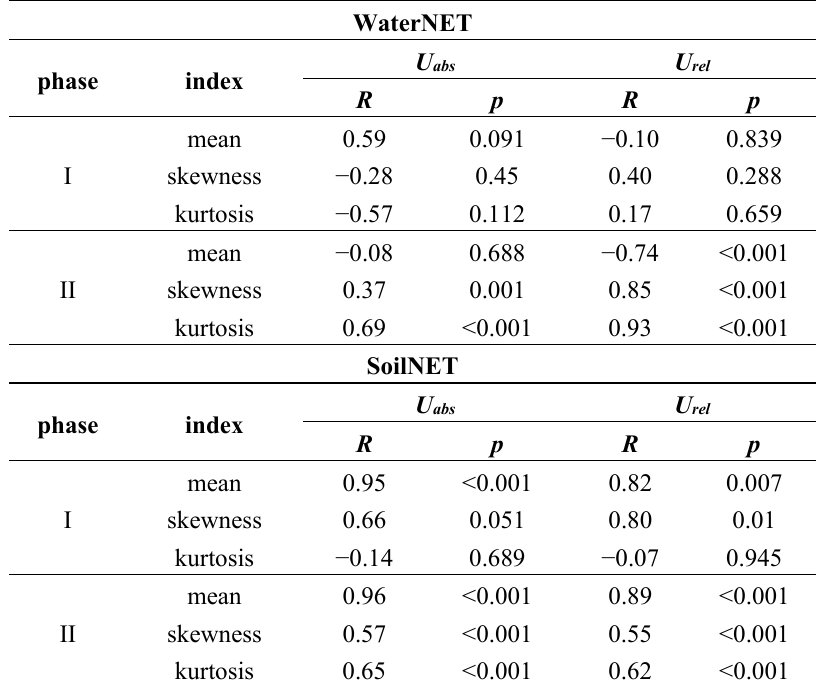
Table 1. Correlations between uncertainties with the mean soil moisture and